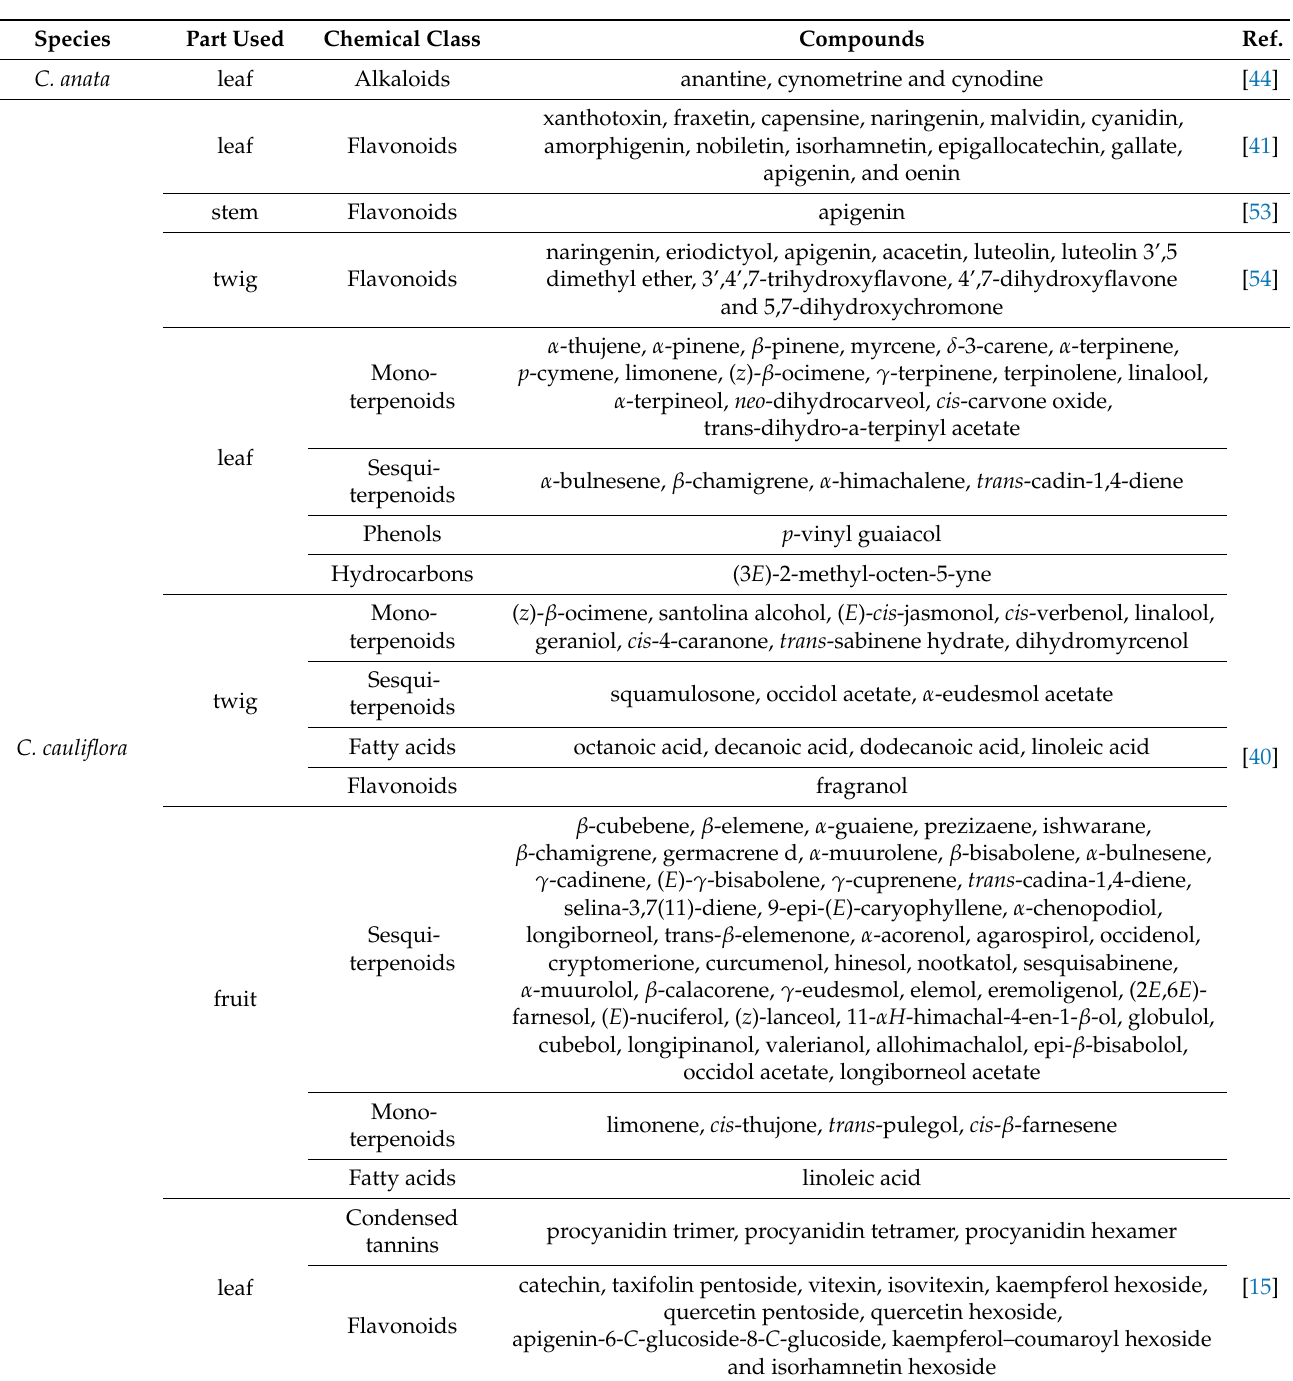
Table 3. Chemical compounds identified from Cynometra